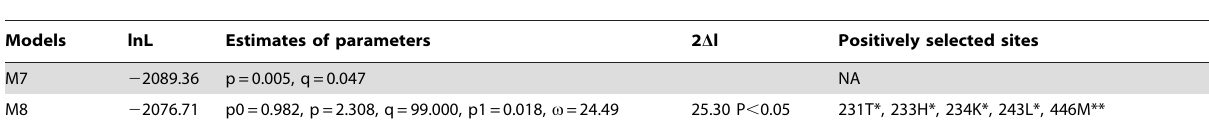
Table 9. Site-specific tests for positive selection on HPV-58 L2.